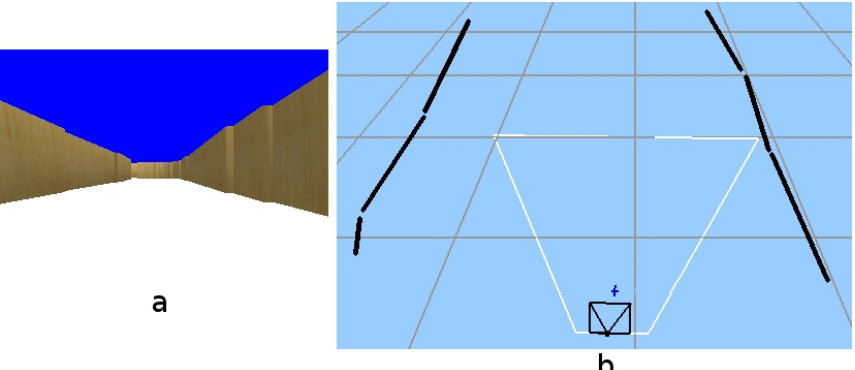
Figure 15. ( a ) Situation; ( b ) Short-term memory achieved after a while.